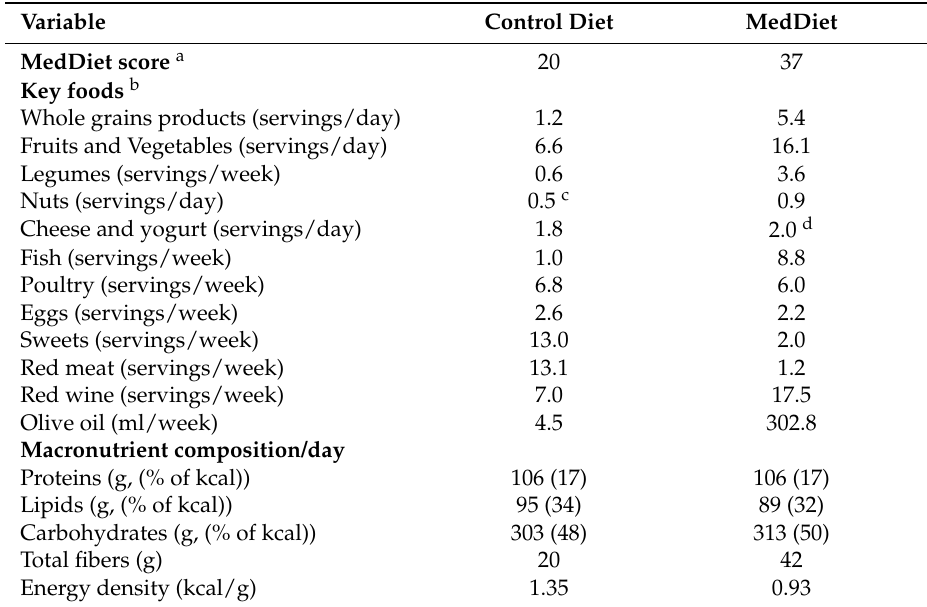
Table 1. Composition of the prescribed North American control diet and MedDiet.